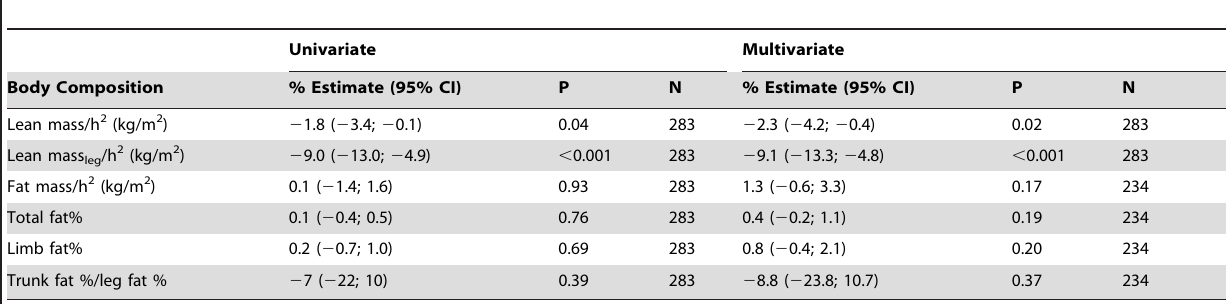
Table 3. Subgroup analyses of body composition and suPAR levels in patients with DXA scan.